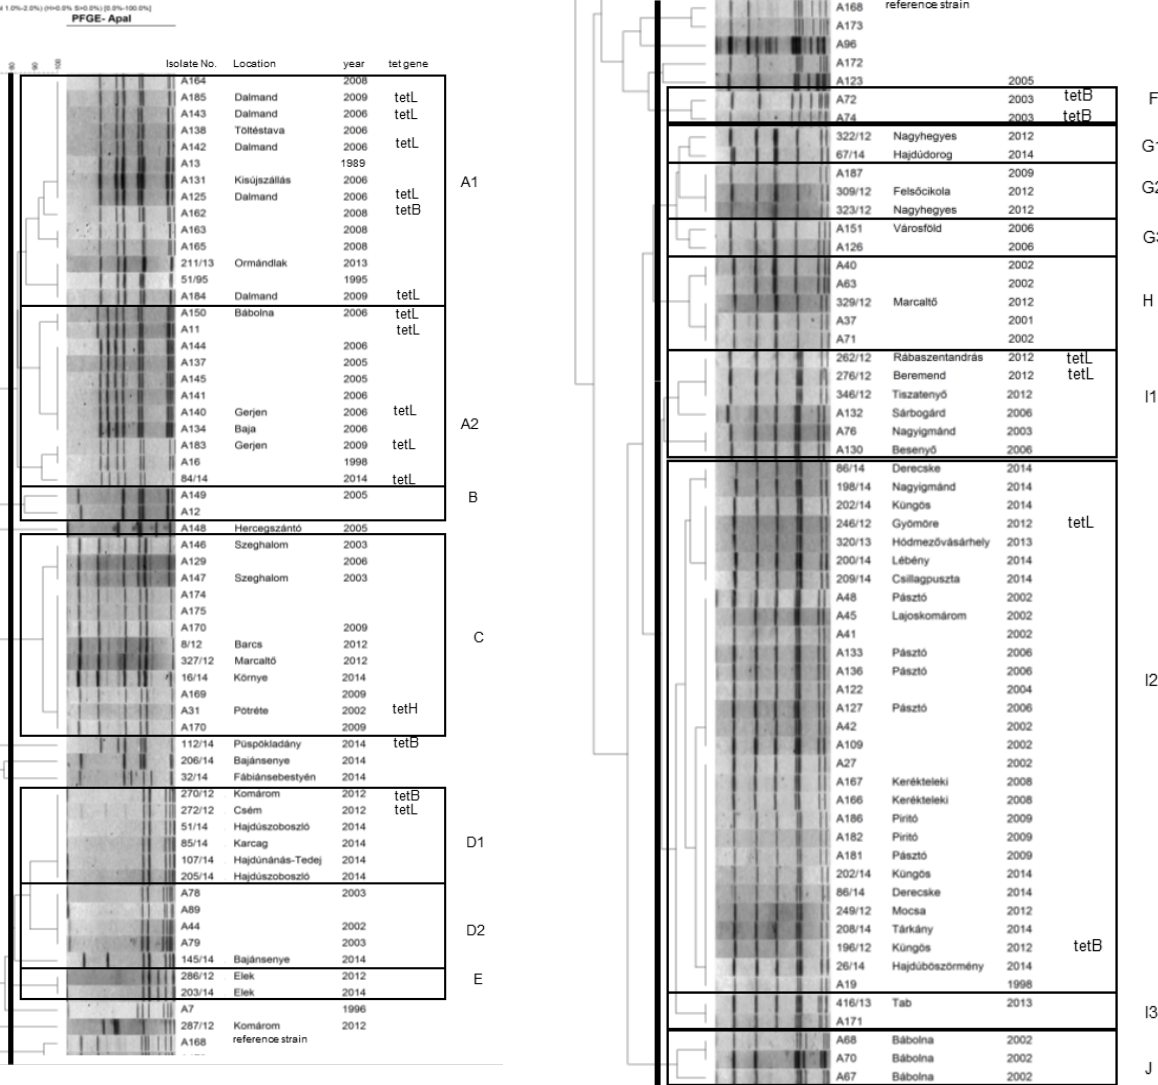
Figure 1. Dendrogram of Actinobacillus pleuropneumoniae isolates based macrorestriction by pulsed- field gel electrophoresis. The dendrogram was split and set side by side at the reference strain (A168) shown in both parts.